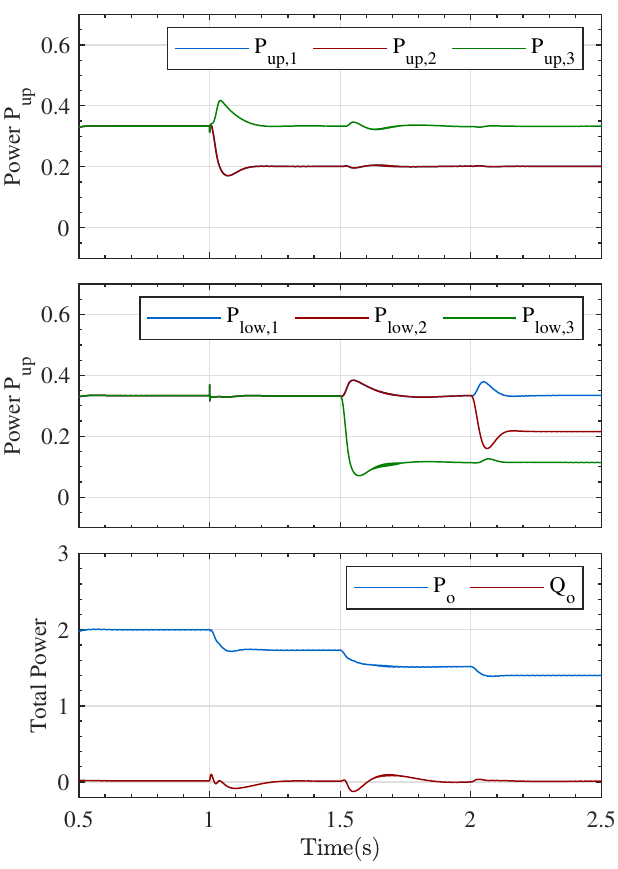
Figure 9. Power response. Active power in upper-arm modules, active power in lower-arm modules, and active and reactive power delivered into the